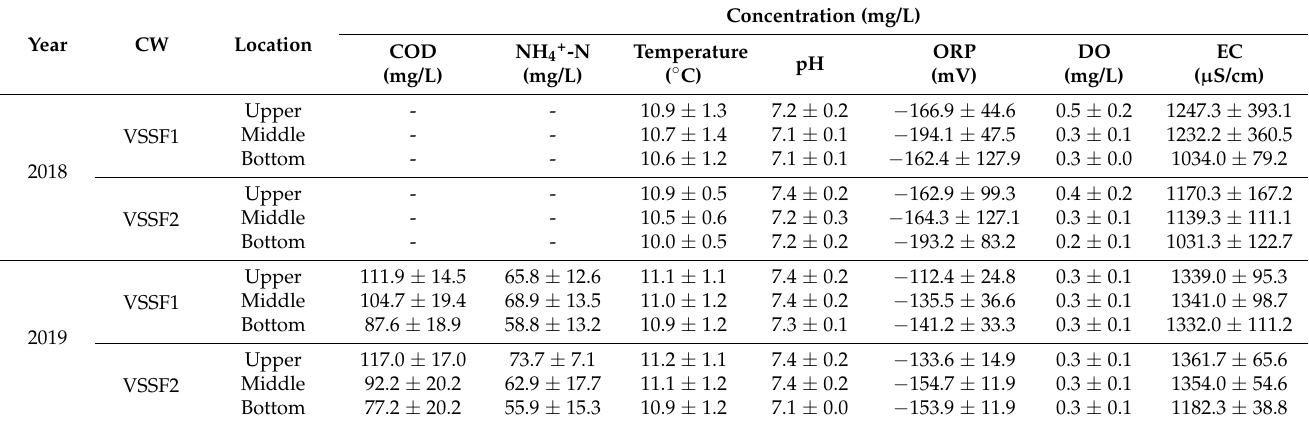
Table 4. Spatial variations of in situ and physicochemical